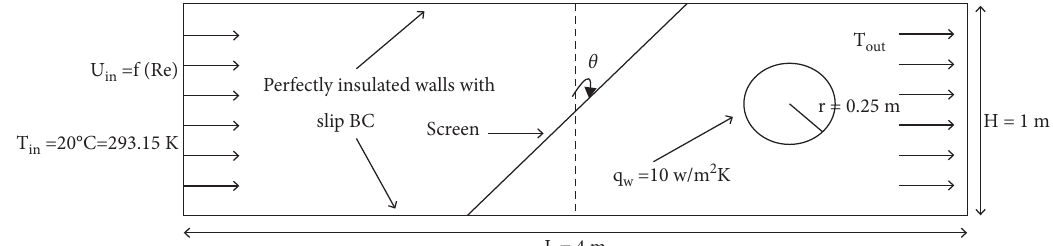
Figure 1: Structure of the rectangular medium under observation [16].